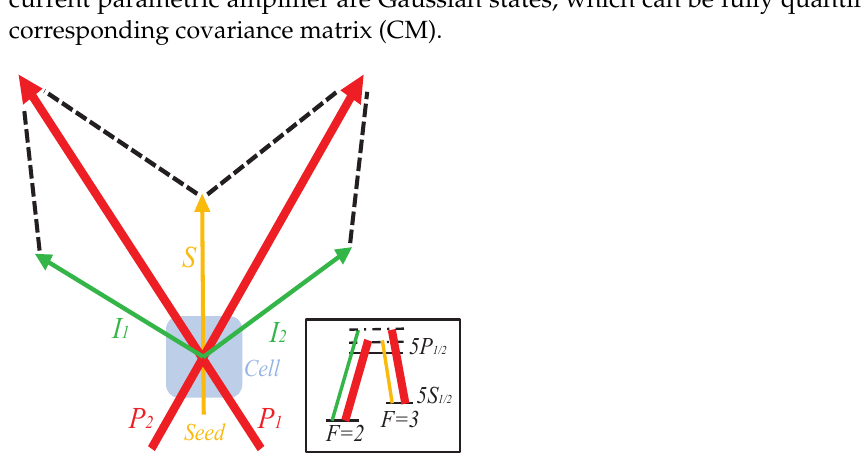
Figure 1. The concurrent parametric amplifier. P 1 and P 2 : two pump beams; S : signal beam; I 1 and I 2 : two idler beams. The energy level is shown in the